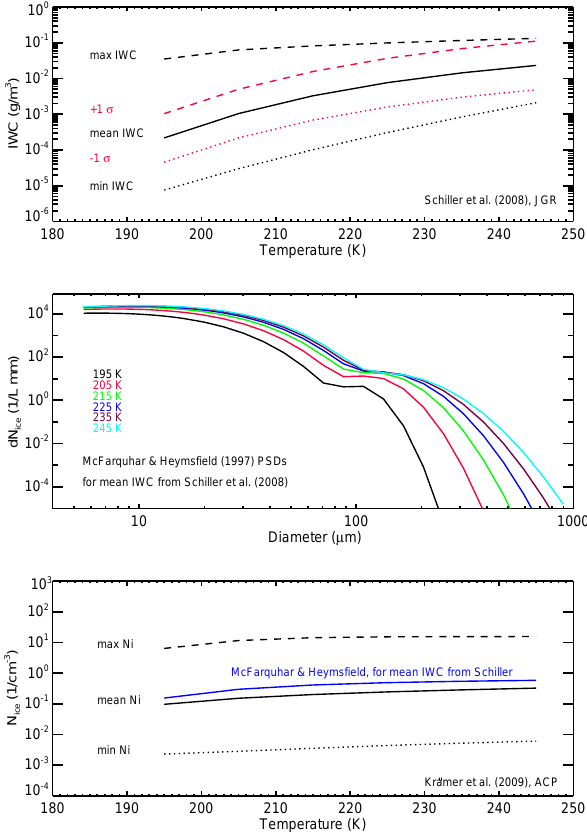
Fig. 1. Top: Minimum, mean, and maximum IWC fits from Schiller et al., the red lines correspond to one standard deviation. Middle: Particle number densities as a function of equivalent-volume diam- eter, based on McFarquhar and Heymsfield’s parameterization and Schiller et al.’s mean IWC. Bottom: Minimum, mean, and maxi- mum total ice crystal numbers observed by Kr¨amer et al. (2009) compared to the total ice crystal number for mean IWC in the present study, shown in